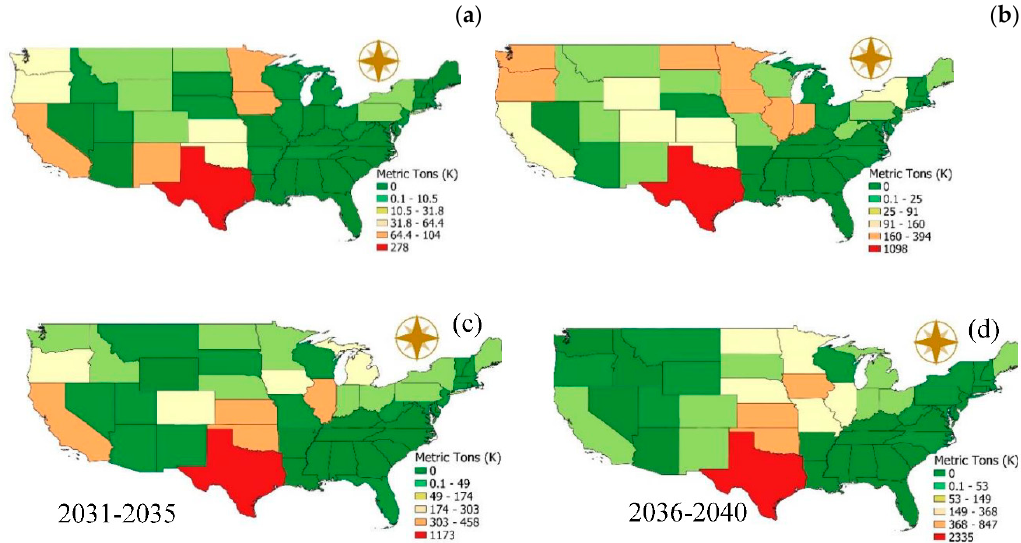
Figure 8. US map showcasing wind turbine mass inventory per state over time considering the following decommissioning periods: ( a ) 2021–2025, ( b ) 2026–2030, ( c ) 2031–2035, ( d ) 2036–2040.